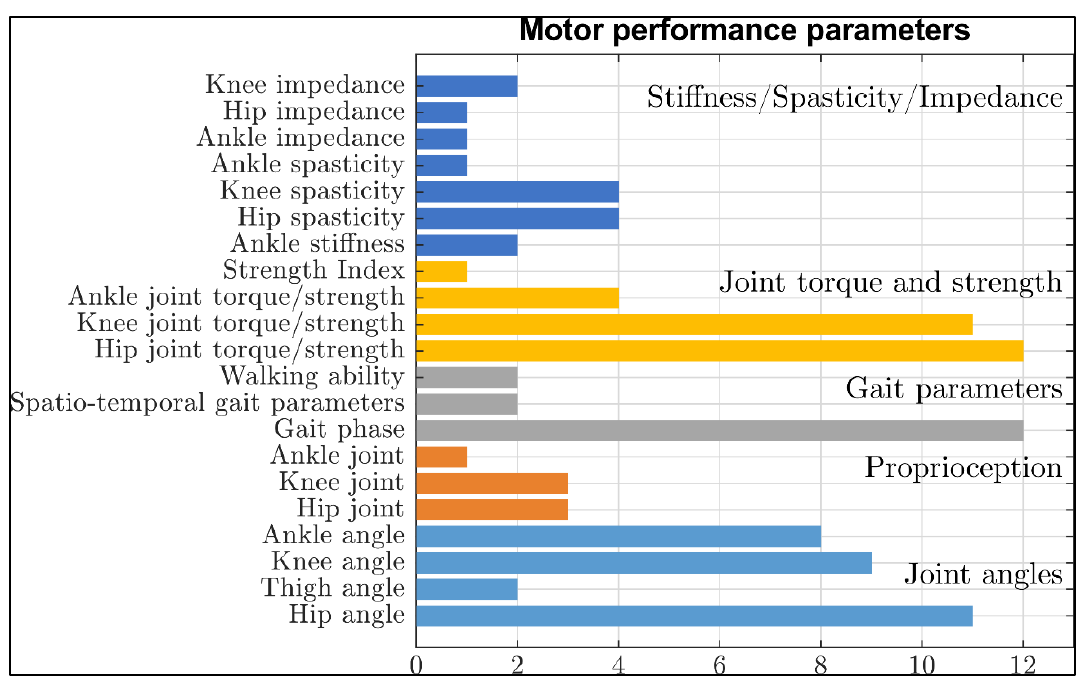
Figure 3. Motor performance parameters assessed in studies (please note that in some studies, multiple parameters were assessed).